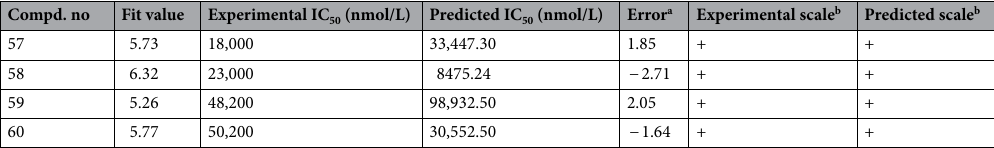
Table 3. Evaluation of predicted and experimental activity (IC 50 ) values of test set compounds using Hypo 1.